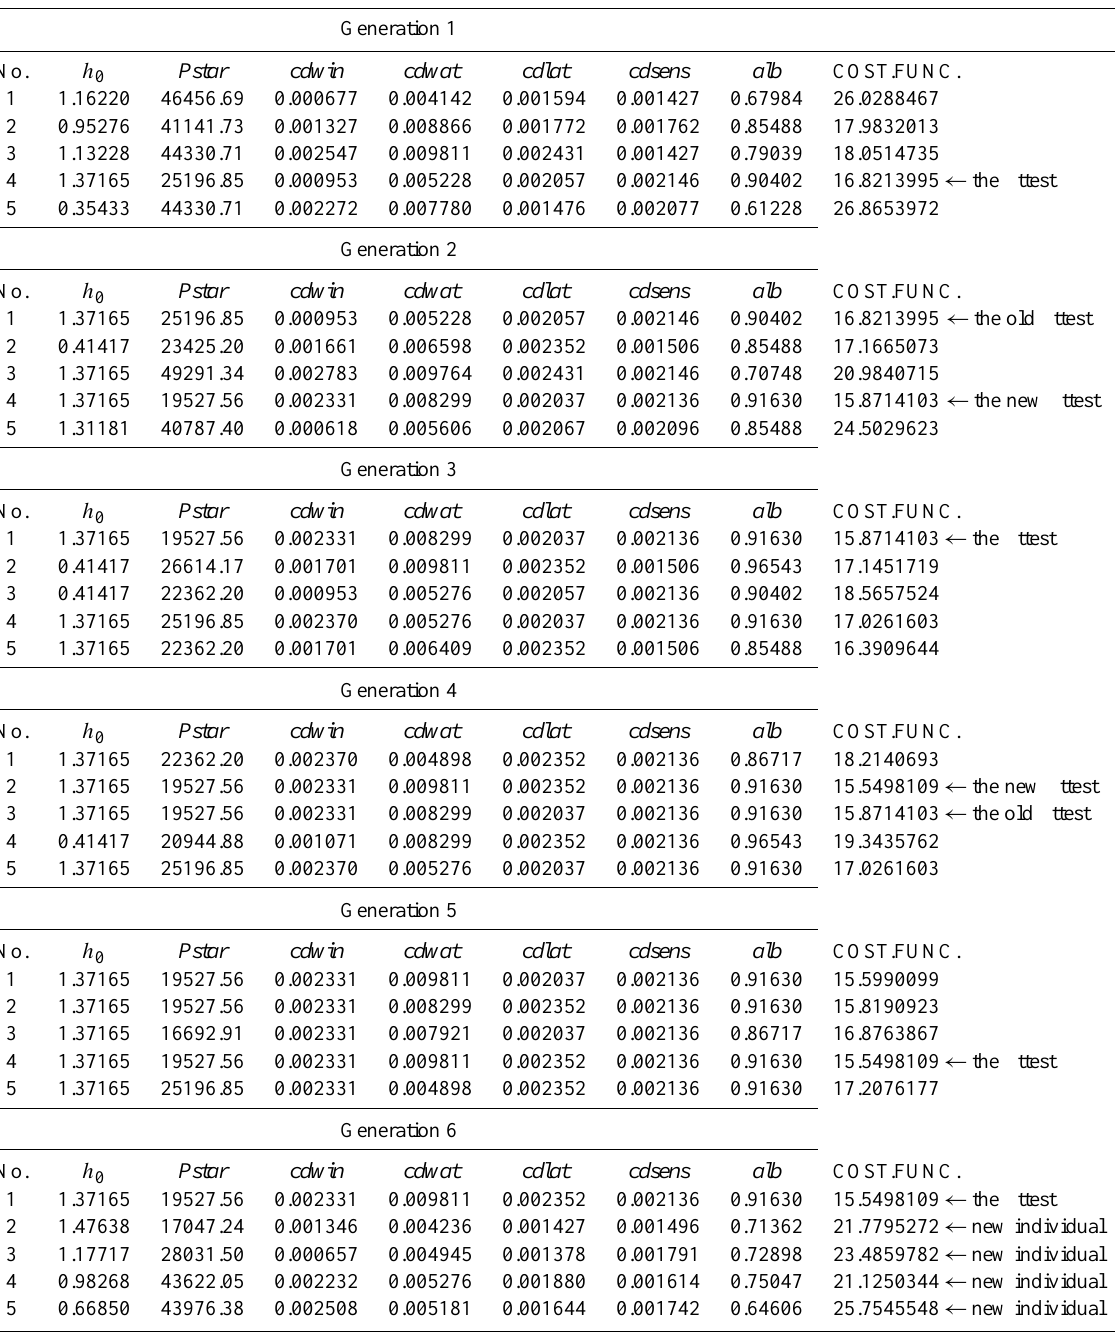
Table A1. Example of evolution of estimated parameter values by the µGA (µGA − 1). Generation